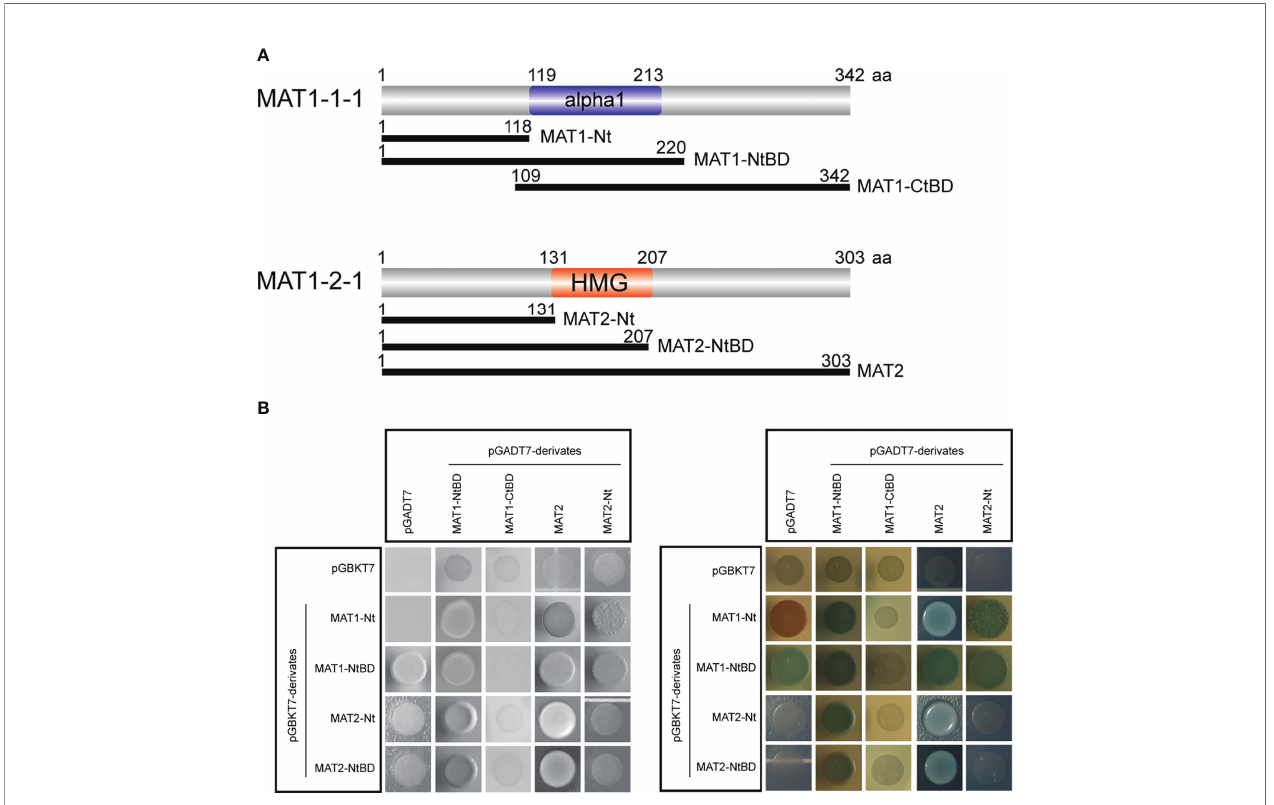
FIGURE 3 | Proteins MAT1-1-1 and MAT1-2-1 physically interact. (A) Schematic representation showing truncated fragments of MAT1-1-1 and MAT1-2-1 TFs. The truncated fragments were fused to Gal4 AD (pGADT7 derivatives; MAT1-NtBD, MAT1-CtBD, MAT2, MAT2-Nt) and to Gal4 BD (pGBKT7 derivatives; MAT1-Nt, MAT1-NtBD, MAT2-Nt, MAT2-NtBD). Gal4 AD, Gal4 activation domain; Gal4 BD, Gal4 binding domain. (B) Yeast two-hybrid analysis of MAT proteins shows that MAT1-1-1 and MAT1-2-1 form homo- and heterodimer complexes. Yeast transformants expressing the Gal4 AD and Gal4 AD fusion constructs were selected on SD-Leu-Trp-His-Ade medium (left panel in black and white). The right panel shows a -galactosidase activity of yeast transformants selected on SD-Leu-Trp-His-Ade medium containing X- a -Gal. Blue color indicates positive protein interactions. Yeast transformants carrying empty plasmids pGADT7 and pGBKT7 were used as a negative